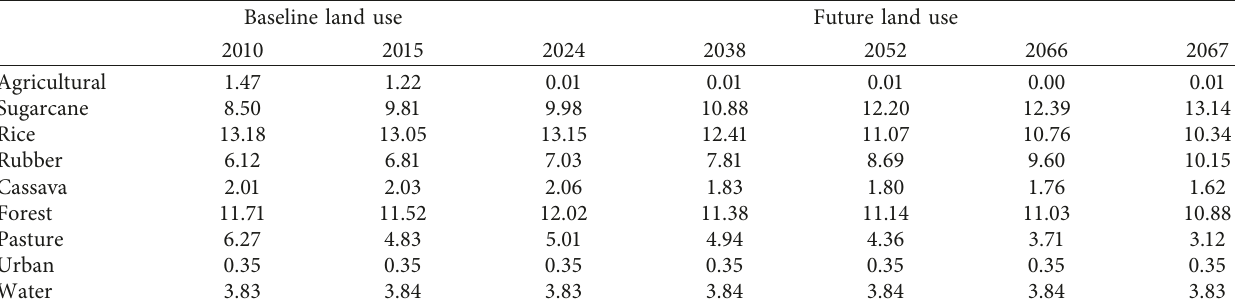
Table 5: Trends of land use change for baseline and future periods above the Huay Ling Jone area (km 2 ).